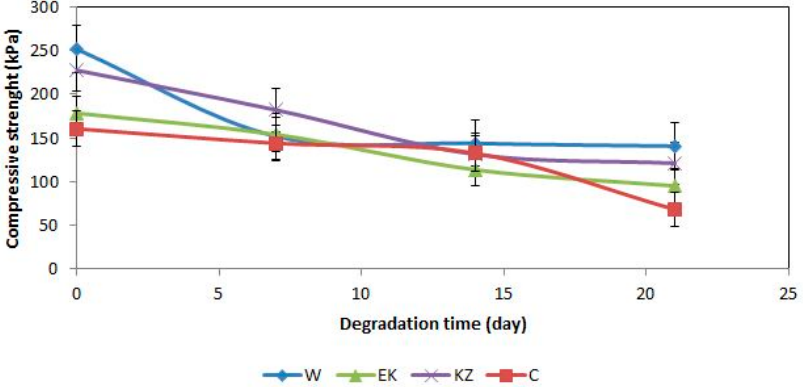
Figure 3. Dependence between compressive strength and degradation time of foams.